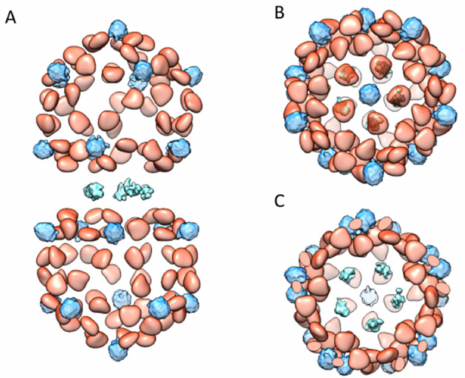
Figure 5. An overall model of known TbCSV DNA densities: ( A ) the side view of the TbCSV DNA densities; ( B ) the top view of the TbCSV DNA densities; and ( C ) the slice view of the TbCSV DNA densities at the interface between two hemicapsids. The model displays the known DNA densities across the entire geminate virion. The densities of ssDNA bound to the CPs are colored in orange, the DNA densities below the capsomers are colored in light blue, and the DNA densities across the interface of two hemicapsids are colored in